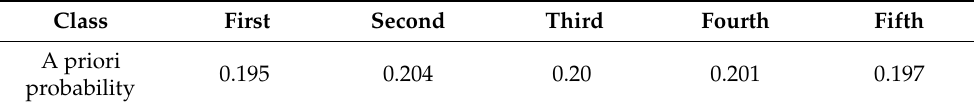
Table 2. A priori probabilities.